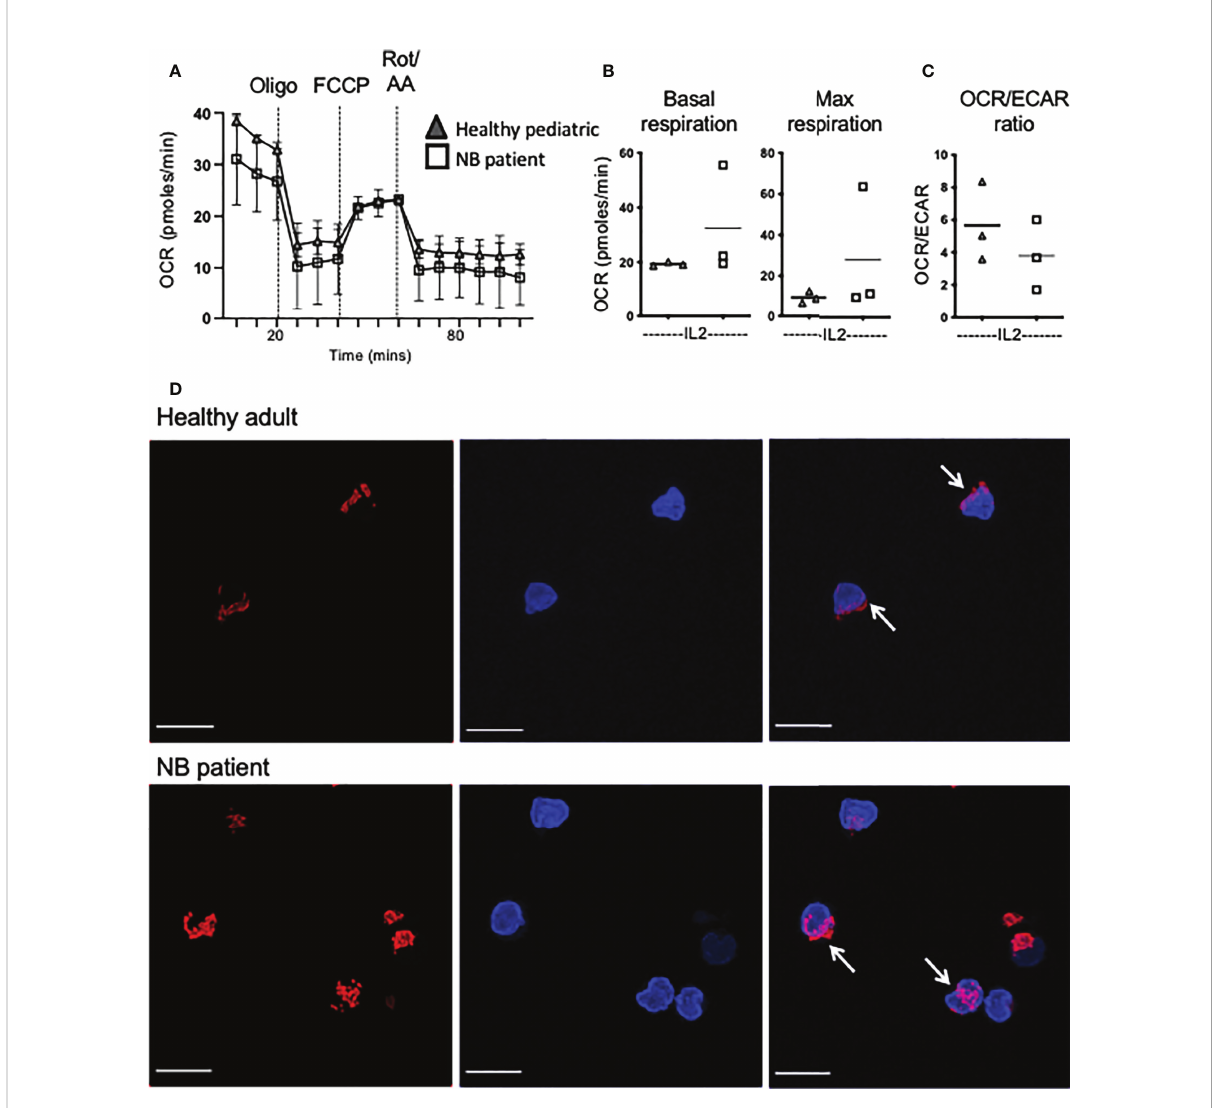
FIGURE 5 Increased dependence on glycolysis in circulating NK cells from patients with neuroblastoma. (A – C) Seahorse analysis of puri fi ed NK cells from healthy pediatric donors and NB patients was performed on the XFp extracellular fl ux analyzer. Dots represent individual donors and horizontal bars show the mean, N=3-14. Samples were compared using the Two-way ANOVA test or Student ’ s t-test. (D) Representative confocal images of puri fi ed NK cells analyzed directly ex vivo from a representative healthy donor and a patient with neuroblastoma (N=1) and stained with MitoSpy CMX Ros (250nM) for 30 min at 37°C and DAPI (300nM). Images shown are the Maximum Intensity projection of Z-stacks taking at 0.2 m m increments. Red= Mitospy CMX Ros, Blue= DAPI. Scale bar=5 m